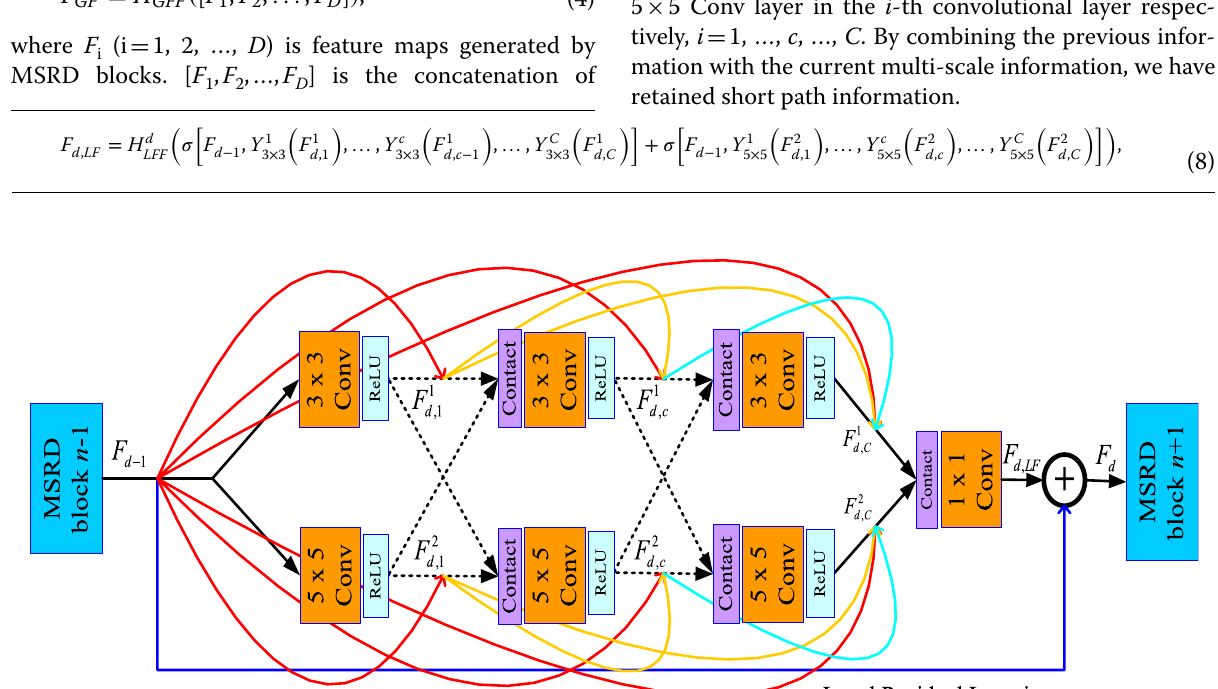
Fig. 2 The architecture of MSRD